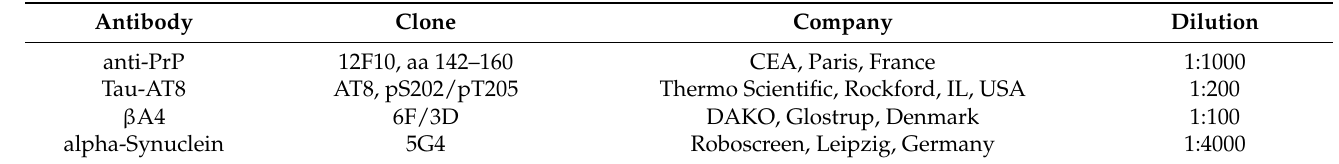
Table 2. Summary of the antibodies used for the immunohistochemical